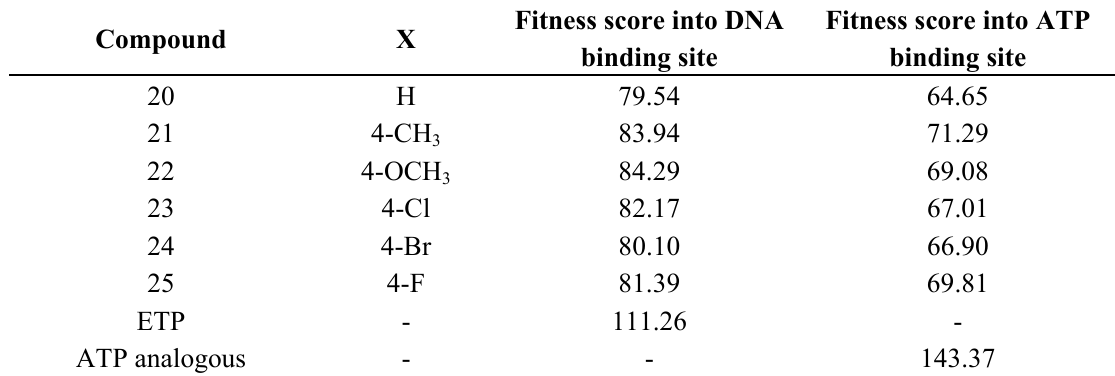
Table 4. Asymmetrically N,N' -substituted urea ( 20 – 25 ), etoposide (ETP) and ATP analogue docking results (ChemPLP scoring function) with the topo II- α DNA and ATP binding